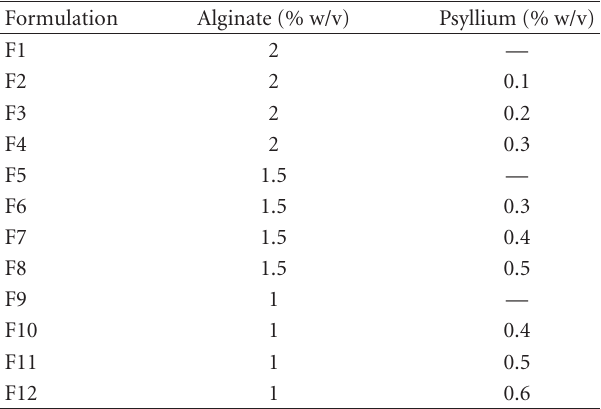
Table 1: Compositions of the studied